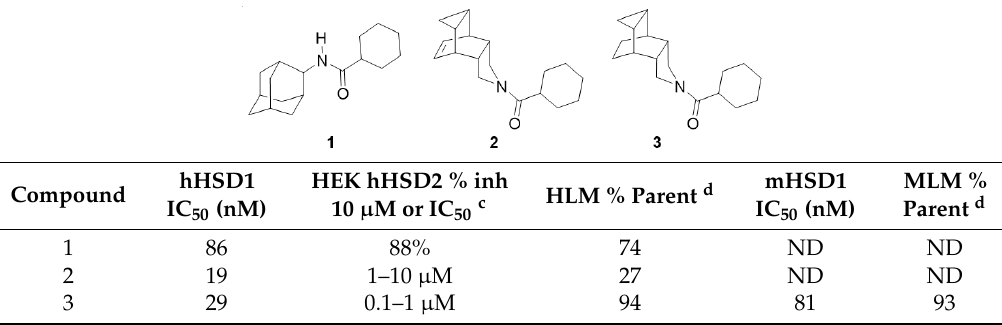
Table 1. Previous 11 β -HSD1 inhibitors reported by the group [15,16] a,b .